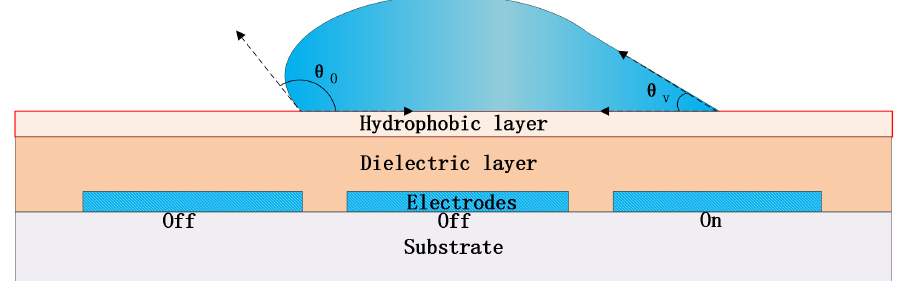
Figure 1. Schematic of the principle of EWOD